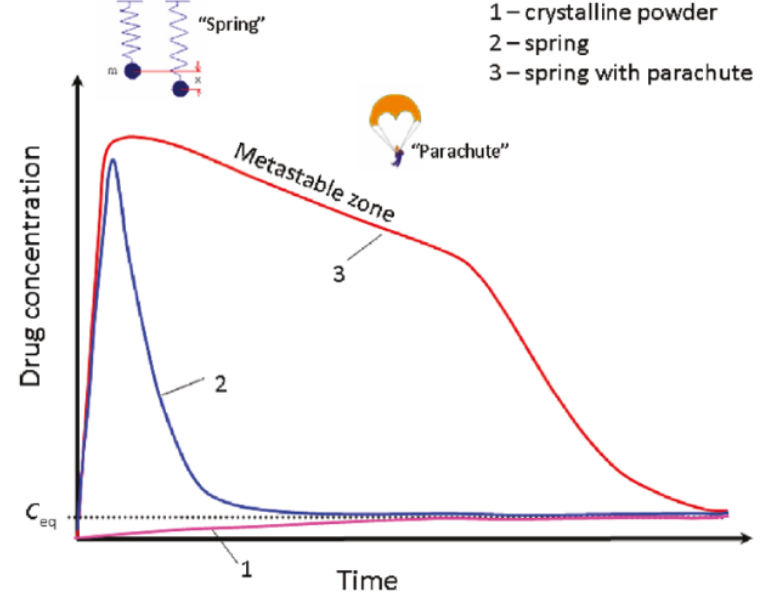
Figure 37. ‘Spring and parachute model’ proposed to explain high apparent solubility of poorly water-soluble drugs [Reprinted from [95] with permission. Copyright 2011 American Chemical Society].